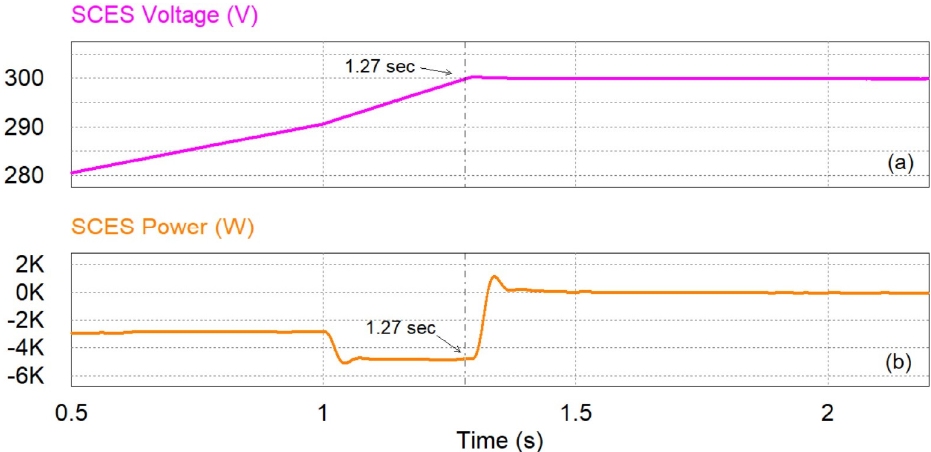
Figure 14. ( a ) The DC bus voltage and the upper voltage limit in the proposed method; ( b ) the DC bus voltage in both methods—Case 2.